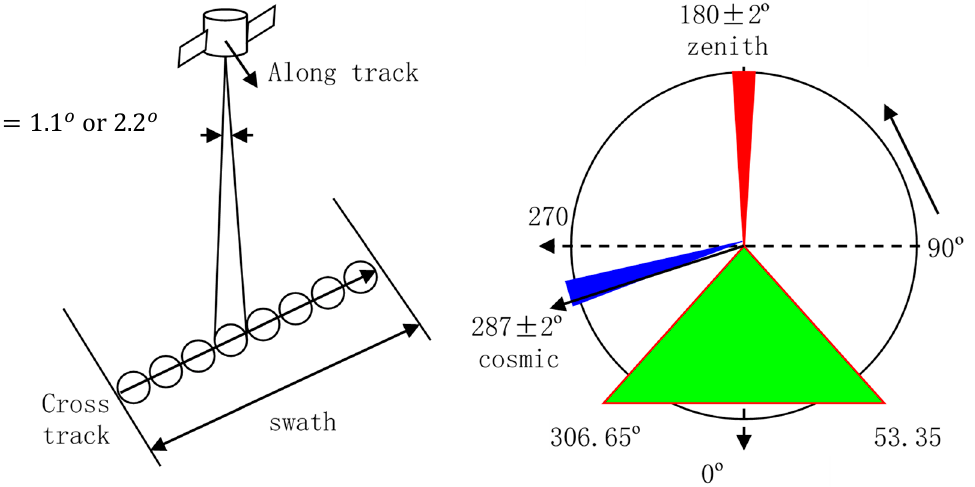
Figure 1. Scanning geometry of the FY-3C MWHTS on orbit.